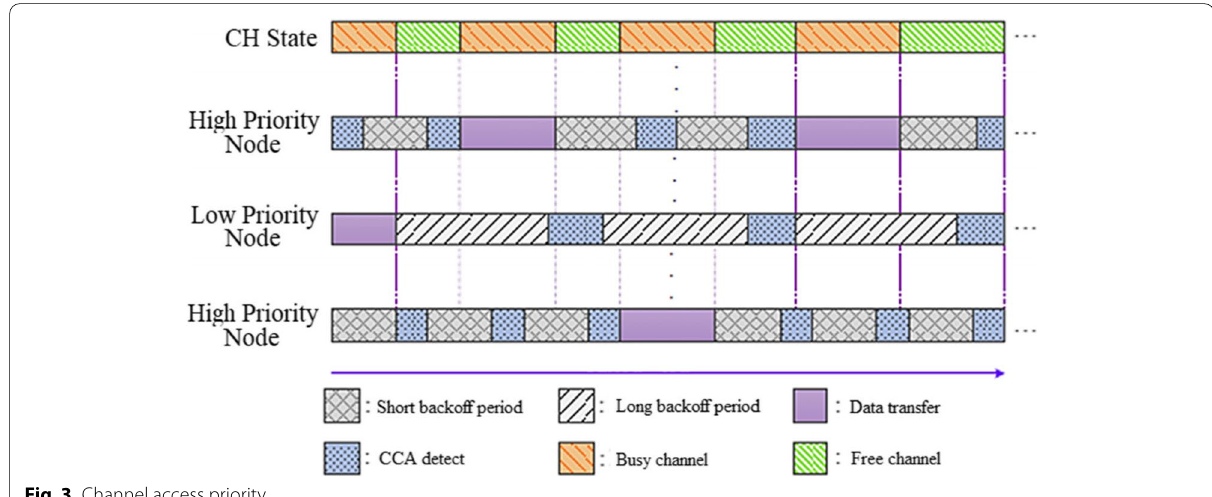
Fig. 3 Channel access